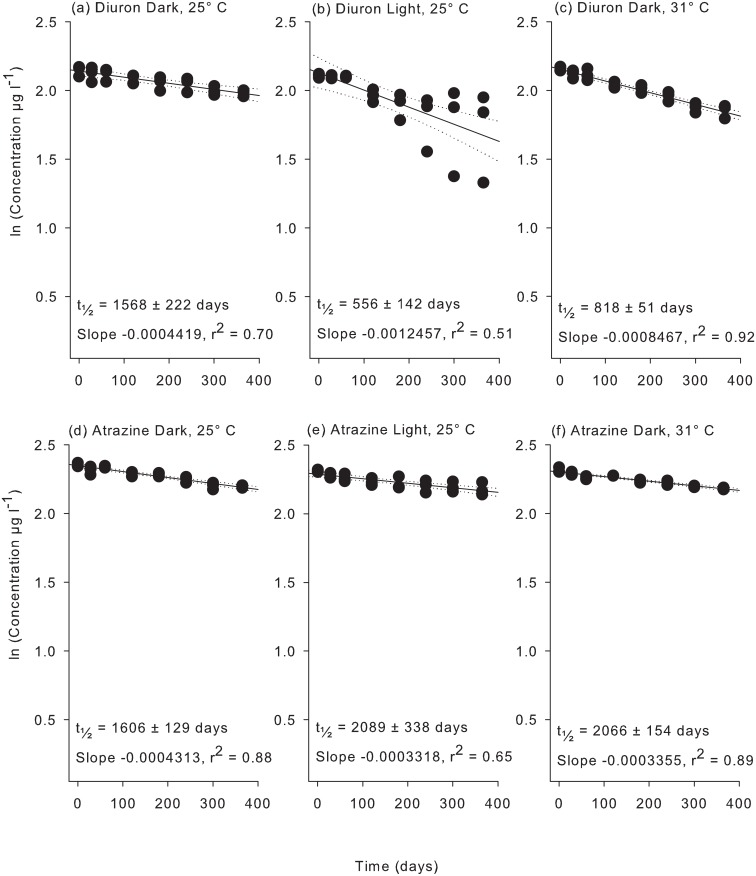
Experiment 2 half-life results for diuron and atrazine.ln(x) concentration of individual herbicide treatments: (a) diuron dark 25°C, (b) diuron light 25°C, (c) diuron dark 31°C, (d) atrazine dark 25°C, (e) atrazine light 25°C, and (f) atrazine dark 31°C over 365 days. Dashed lines represent 95% confidence intervals. Half-life reported ± SE.